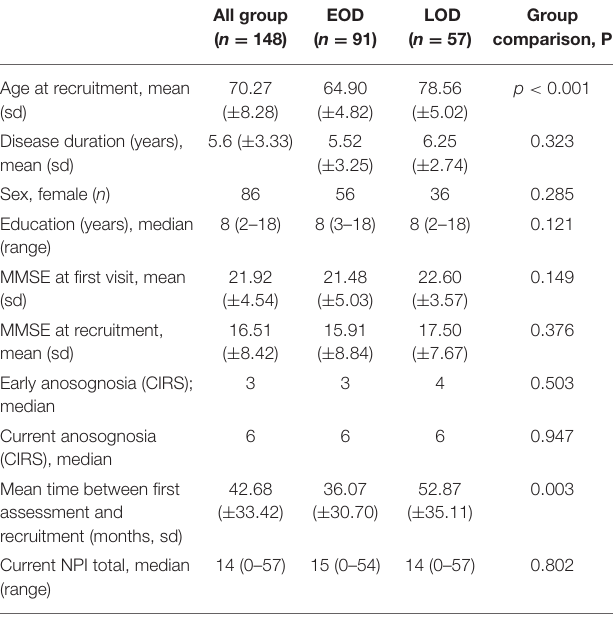
TABLE 1 | Clinical and demographical characteristics of patients included in the